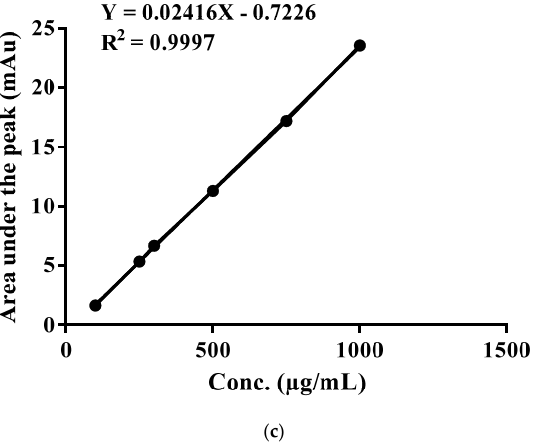
Figure 1. Standardization of EFAM: ( a ) HPLC Chromatogram of the ethyl acetate fraction; ( b ) * HPLC chromatogram of the isolated isorhamnetin-3- O -rutinoside (the purity of the isolated isorhamnetin-3- O -rutinoside is 99%); ( c ) calibration curve of the isolated isorhamnetin-3- O - rutinoside.